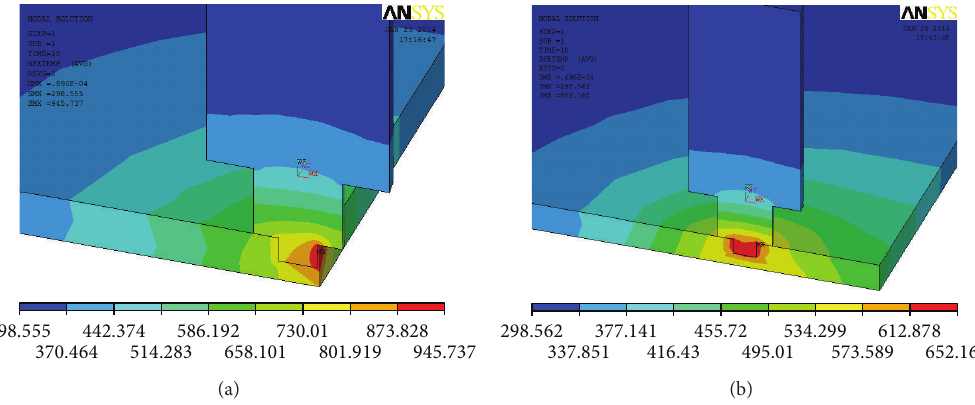
Figure 10: Temperature contours results of FEM simulation. (DT = 40 s and temperature is in Kelvin). (a) 𝑥 1 = 3 mm and (b) 𝑥 1 = 30 mm. The temperatures values are in Kelvin.